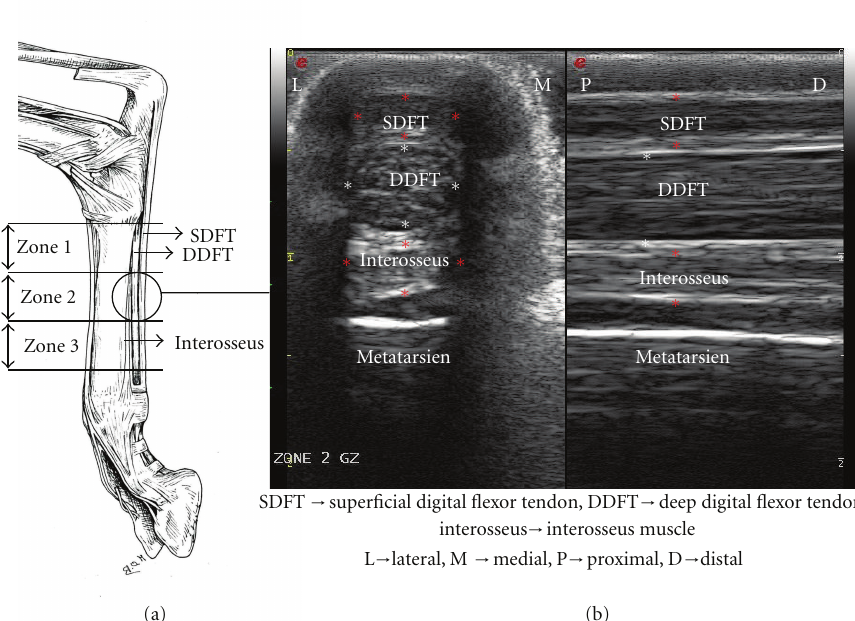
Figure 1: (a), anatomy of the goat’s hind limb. (b), transversal and longitudinal US images of zone 2.